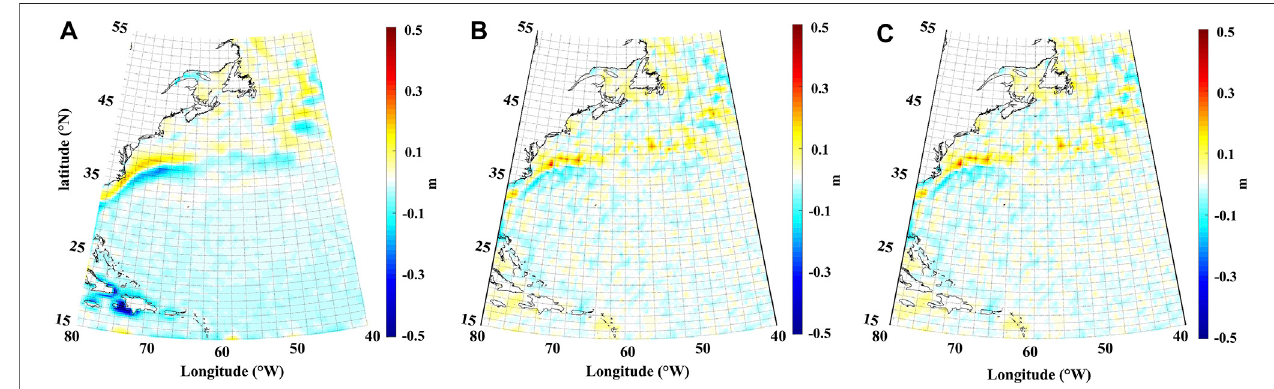
FIGURE3| Mis fi tsbetweenestimatedMDTsusingGOCO06sagainsttheSynthetic_MDT.[ (A) Gaussian fi lteredMDT, (B) estimatedMDTwithfullerrorinformation of GGM, and (C) diagonal error information of GGM, against the Synthetic_MDT. The cs 1 is d/o 260.]